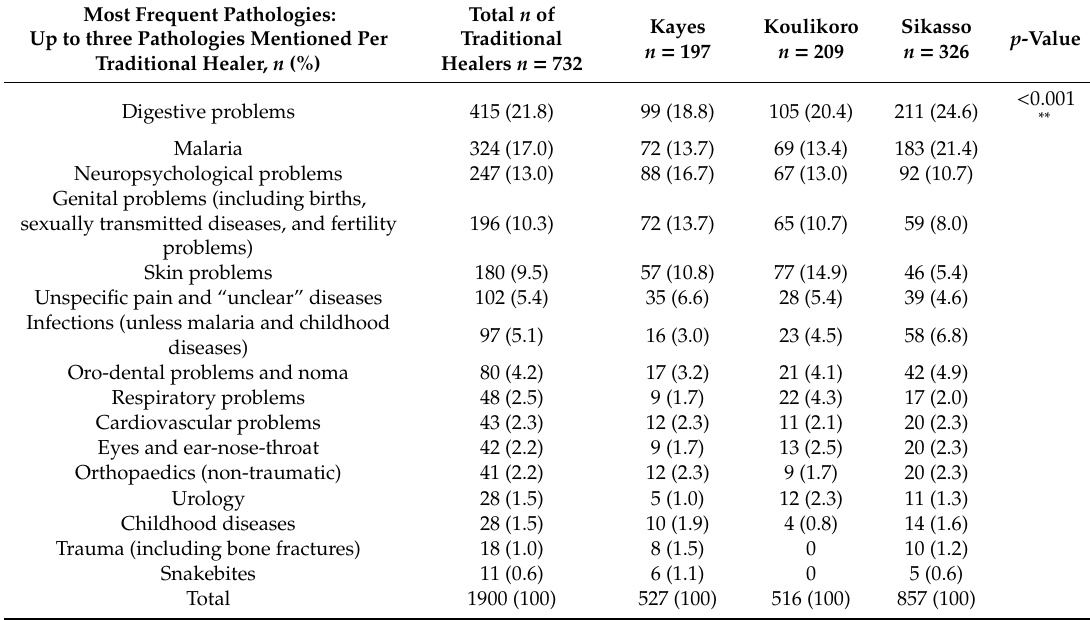
Table 2. Most frequent pathologies treated by the traditional healers (by category) *.